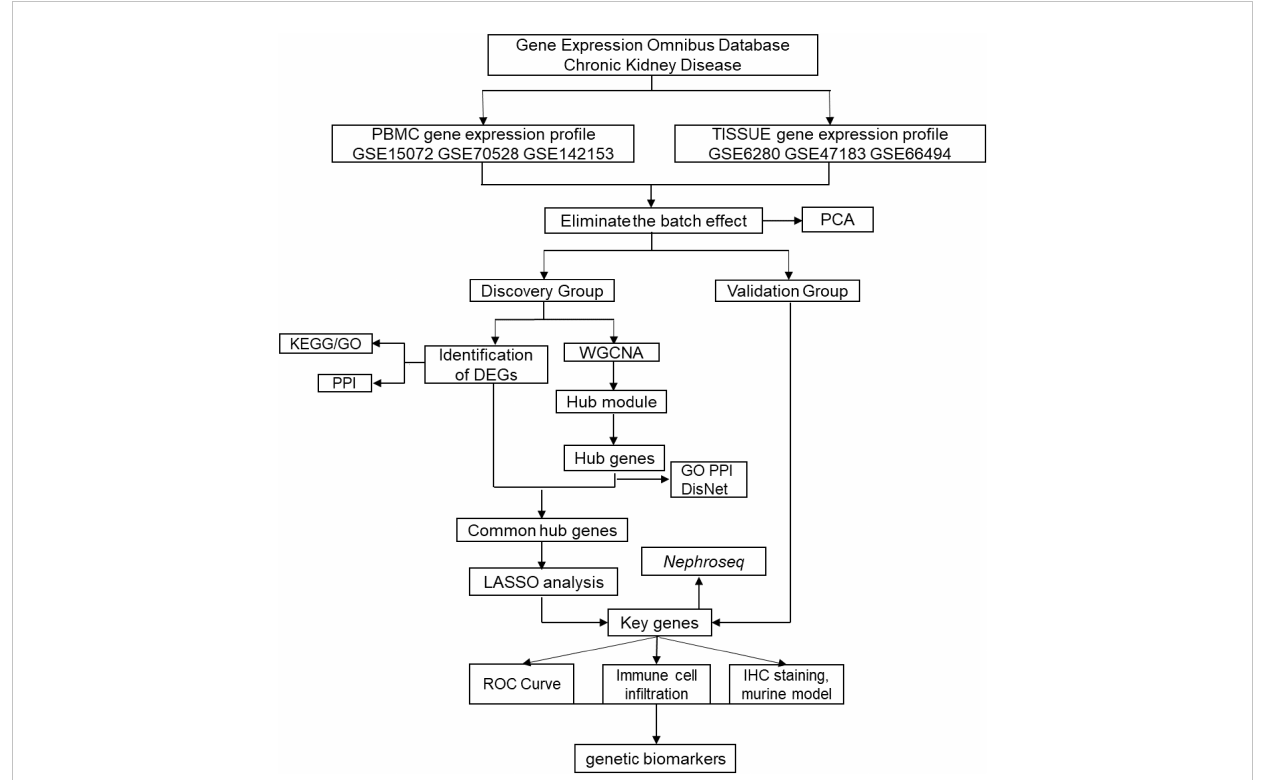
FIGURE 1 Flowchart to identify chronic kidney disease (CKD) biomarkers, including data extraction, processing and